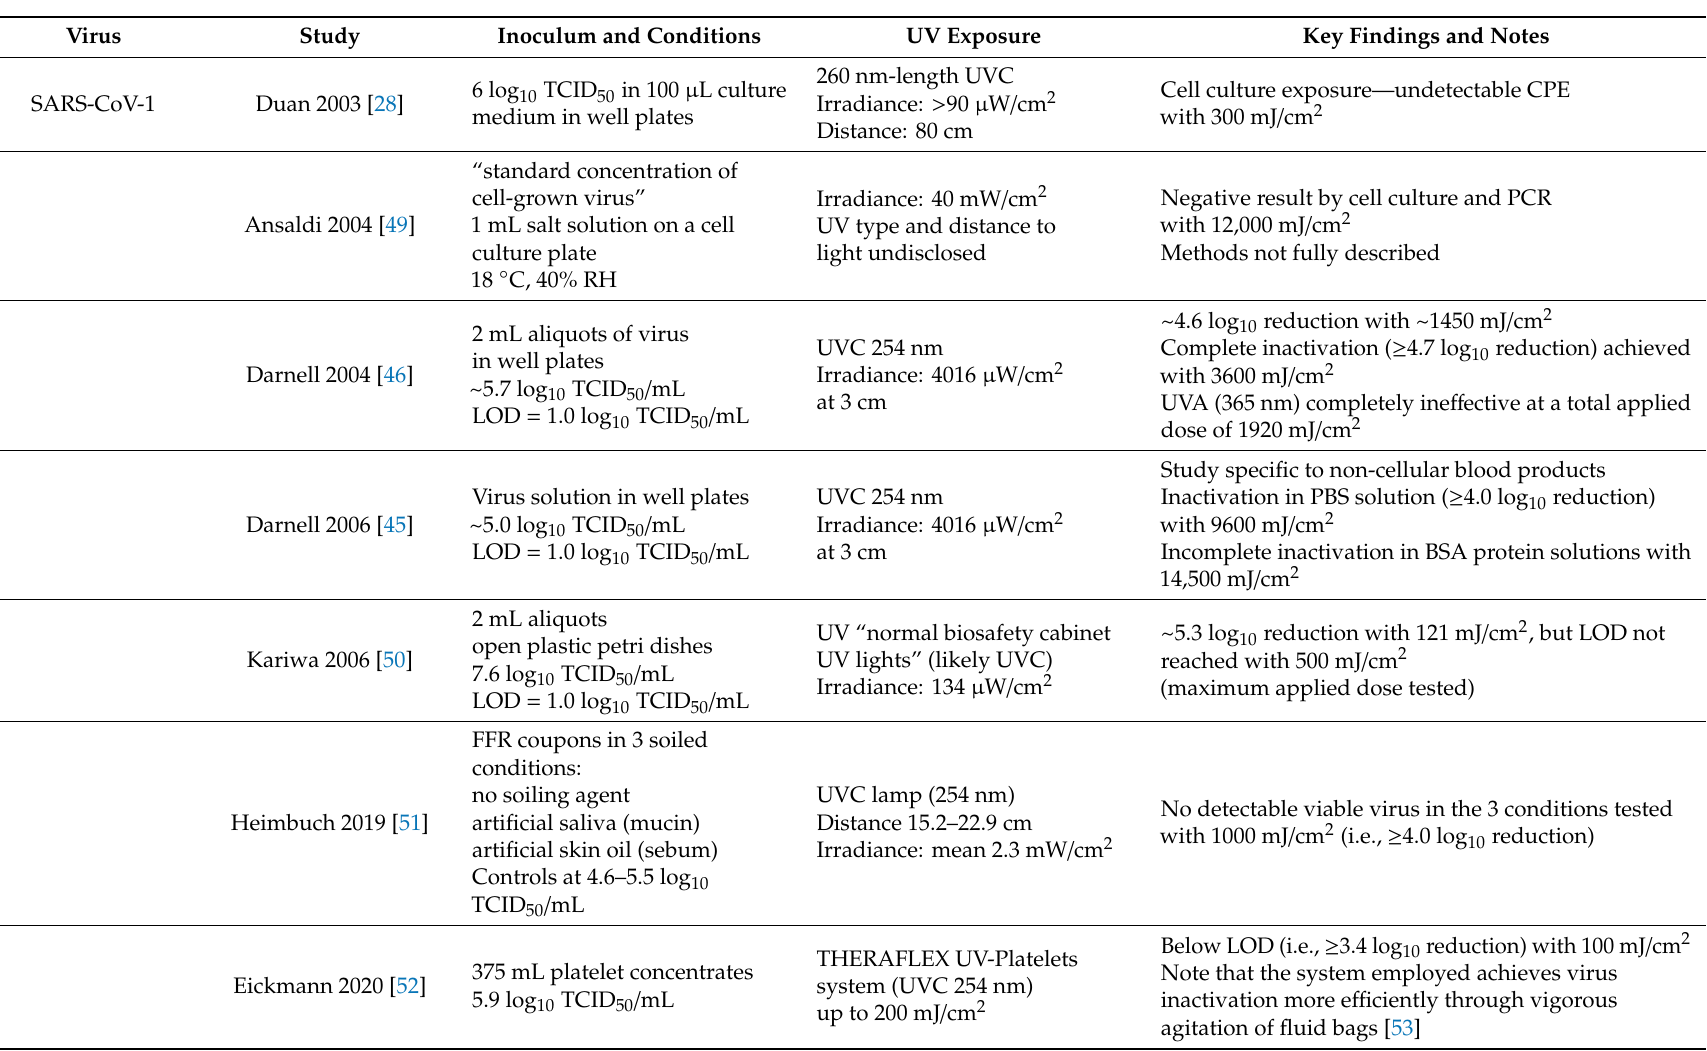
Table 4. Studies reporting on the e ffi cacy of ultraviolet germicidal irradiation (UVGI) against SARS-CoV-1 and SARS-CoV-2.